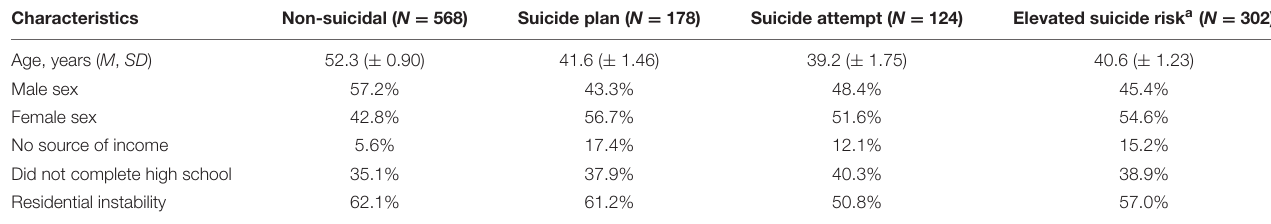
TABLE 1 | Descriptives of non-suicidal and elevated suicide risk